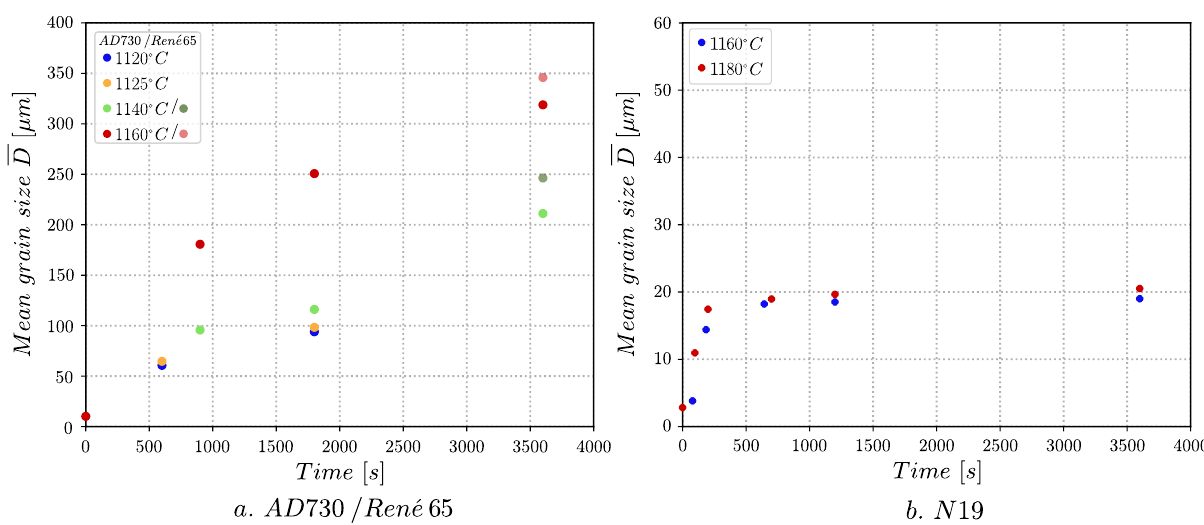
Figure 9. Grains mean size after supersolvus heat treatments for ( a ) AD 730/ René 65 and for ( b ) N 19